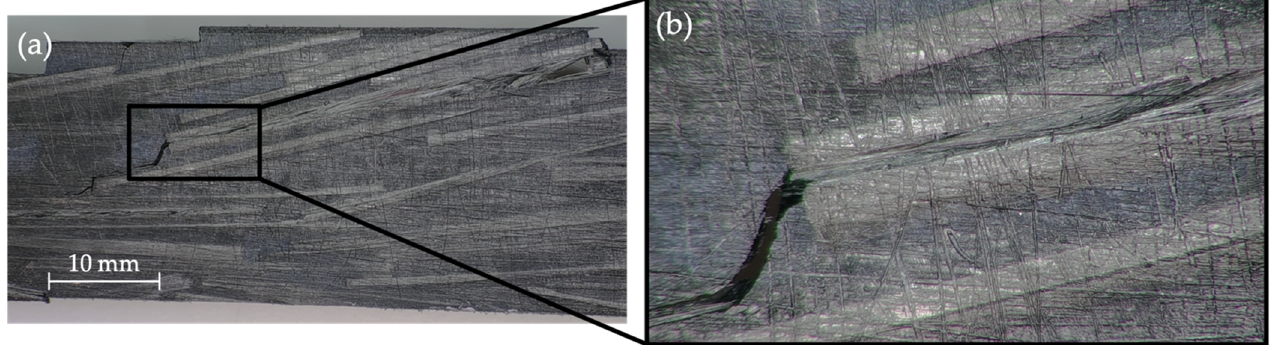
Figure 7. Digital microscopy images of a PA11 composite after fatigue. ( a ) magnification of 10×; ( b ) magnification of